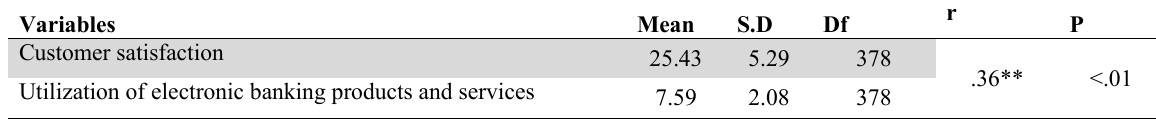
Pearson correlation test showing the relationship between e-product and services utilisation and Customer satisfaction